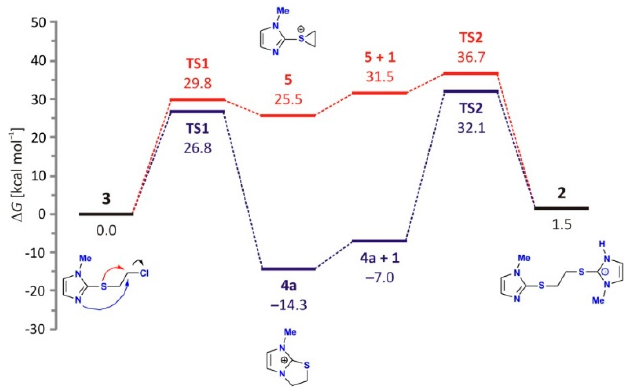
Figure 12. Reaction profiles for the conversion of 3 into 2 with the external nucleophile 1 proceeding through (i) a thiiranium ion 5 intermediate (in red), and (ii) a five-membered 4a intermediate (in blue). Relative energies of stationary points are obtained at the (SMD)/M06–2X/6–31+G(d) model.